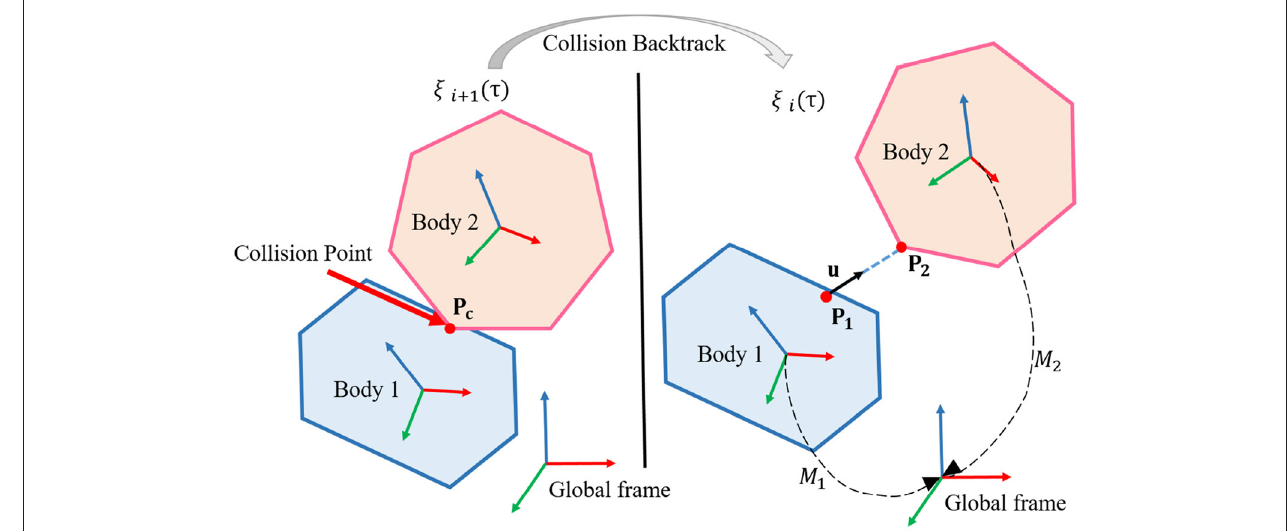
FIGURE 3 | Diagram for collision